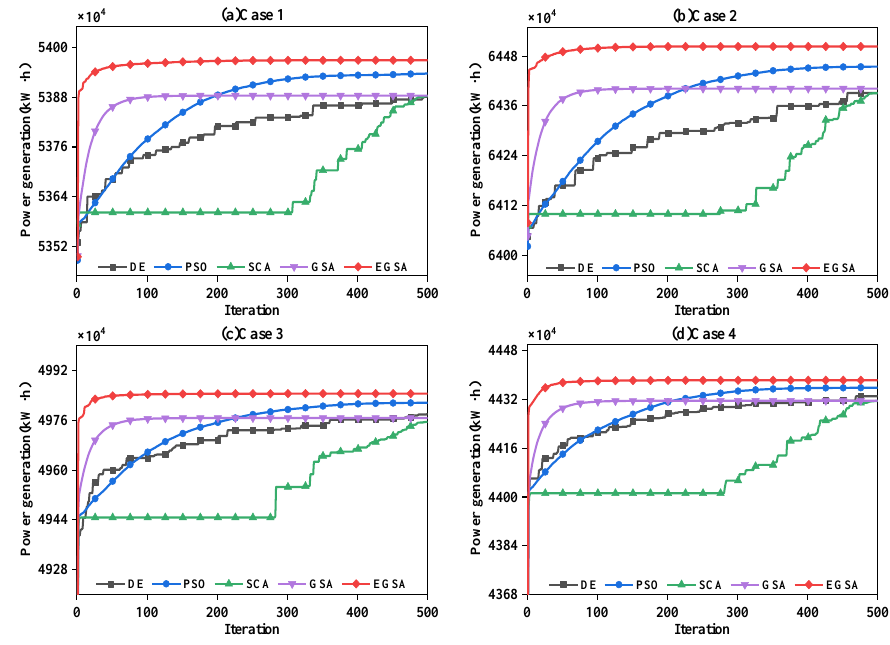
Figure 8. Convergence trajectories of 5 methods in different cases.